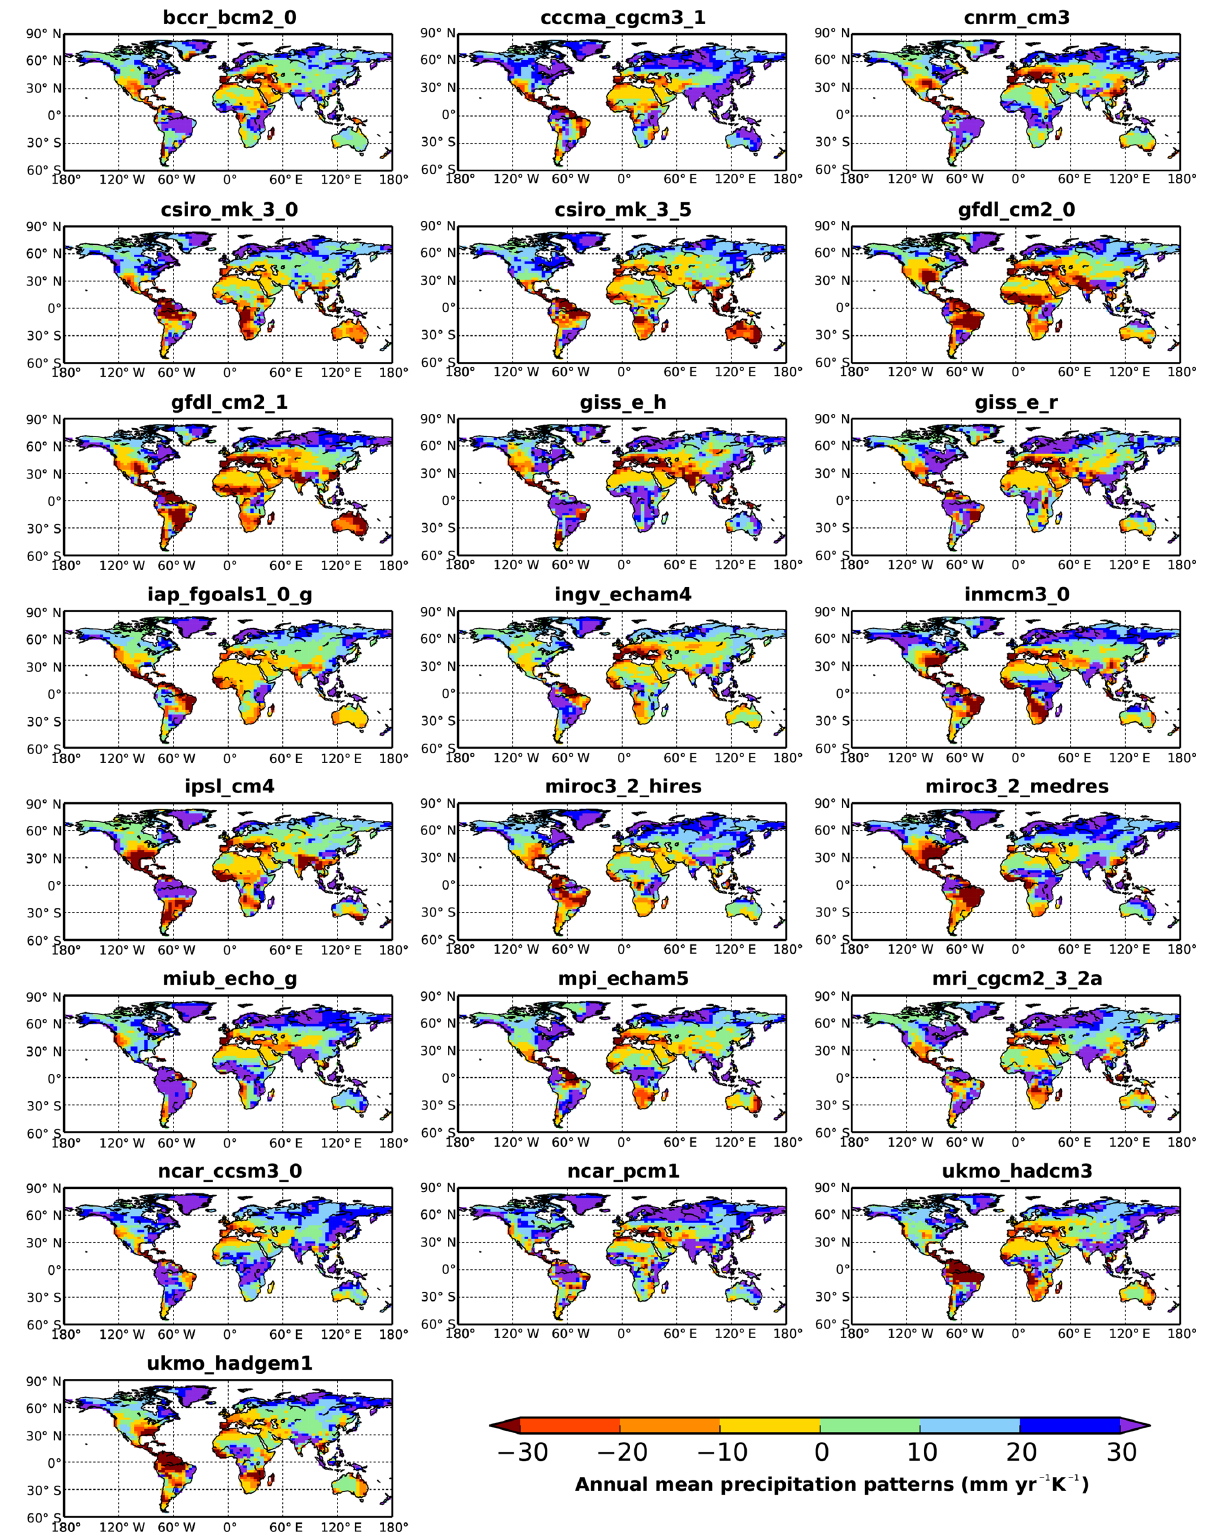
Figure 3. Annual means of the monthly patterns of local precipitation change per degree warming over all land (mmyr − 1 K − 1 ). Data presented for the 22GCMs considered in this